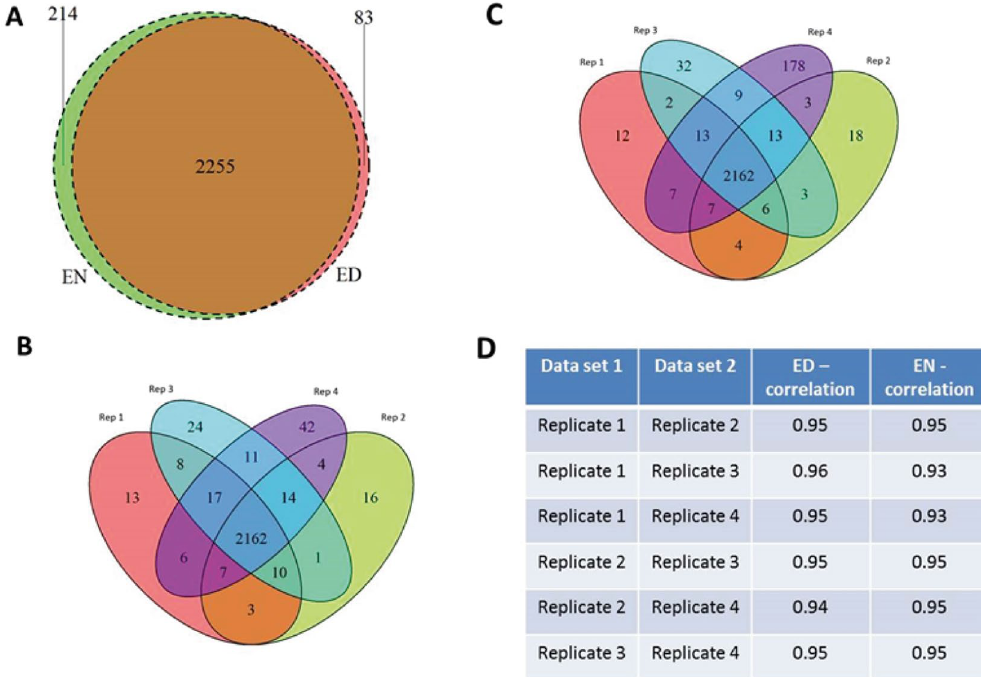
Figure 2. Evaluation of protein identification and reproducibility within the datasets. Label free quantification of the raw spectral information was performed in MaxQuant to produce protein datasets at the ED and EN. ( A ) The overlap between all identified proteins at the ED and EN was represented as a Venn diagram. ( B ) As a measure of reproducibility the overlap of the 4 biological replicates at the ( B ) ED and ( C ) EN was calculated and visualised as a Venn diagram. ( D ) A Pearson’s correlation matrix was performed as an additional measure of reproducibility at the protein level. Correlation factors were calculated for proteins in a pairwise manner across the entire matrix for each fraction of each biological replicate versus